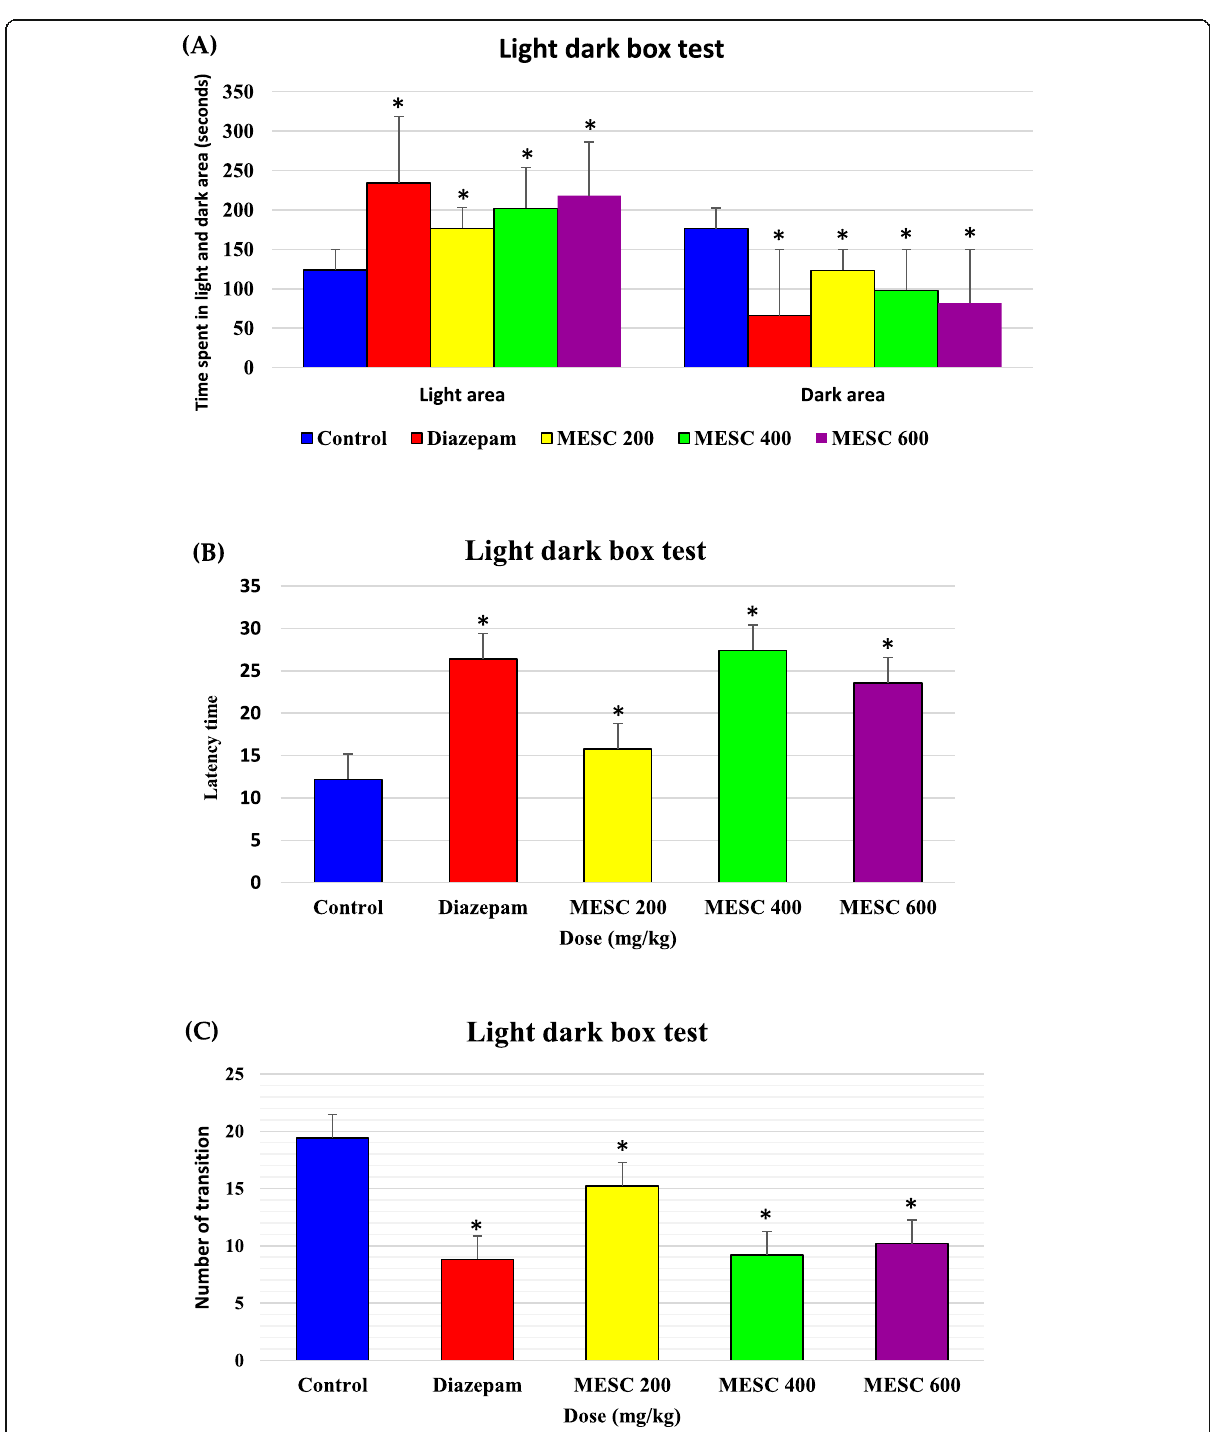
Fig. 4 The anxiolytic effect of MESC on light-dark box test in mice. a Time spent in light and dark area; b Latency time; and c Number of transition. i. * p < 0.001 vs control group. ii.** p < 0.0001 vs control group. [Control (NaCl saline 0.1 ml/ mouse), Diazepam (1 mg/kg B.W.), MESC (200, 400 and 600 mg/kg